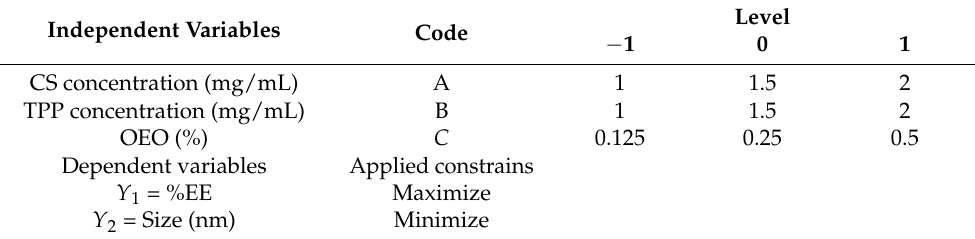
Table 1. The code and level of independent variables used in response surface design. Independent Variables